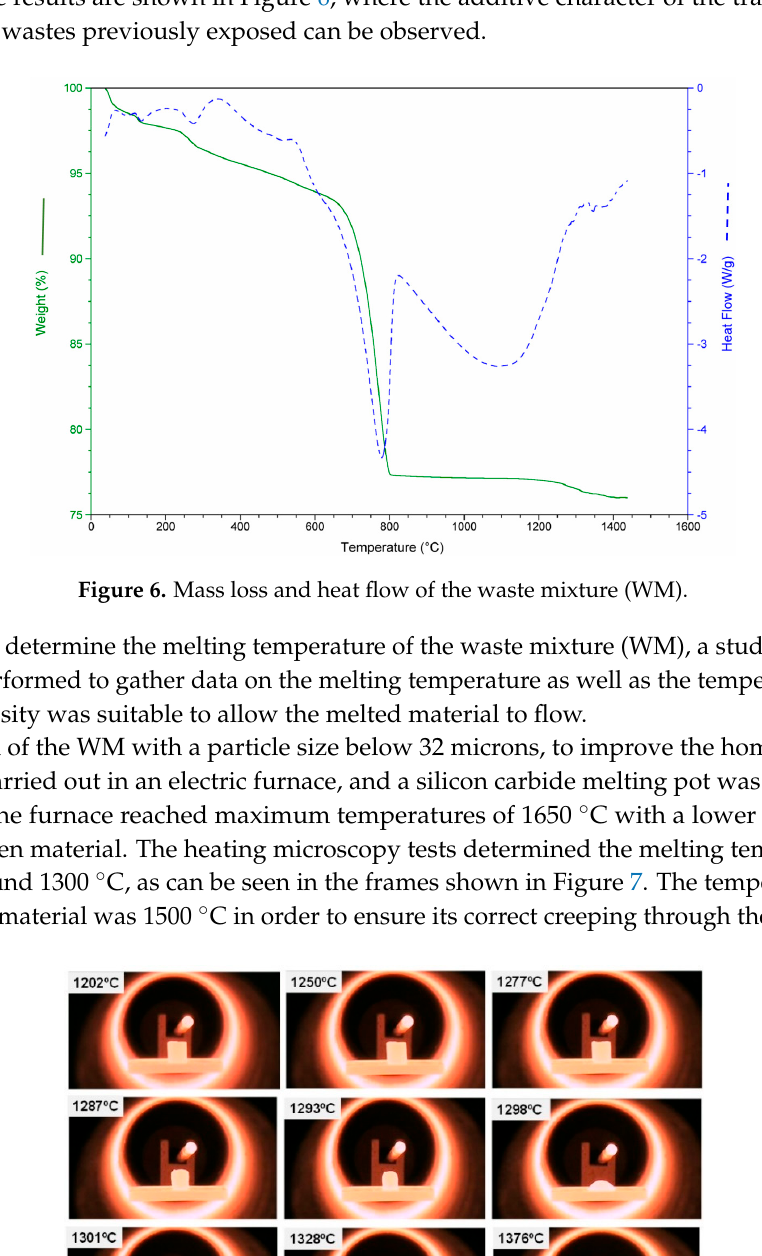
Figure 5. Mass loss and heat flow of aluminum recovery plant (AW).